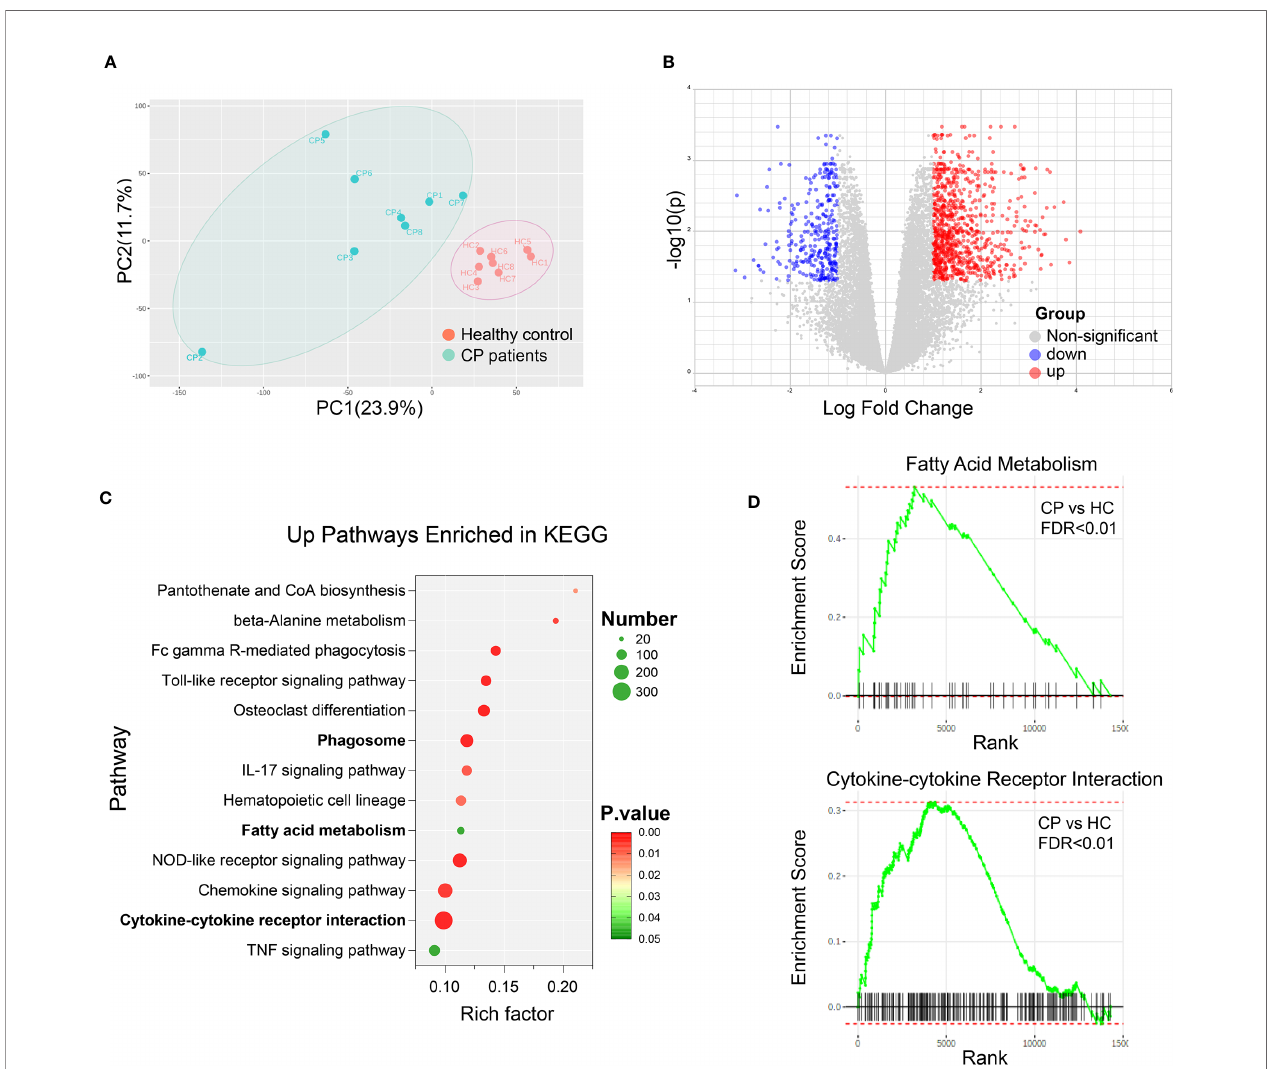
FIGURE 2 | Bile Acid Metabolism is Associated with the Altered Signalings in CP Patients. Peripheral blood mononuclear cells (PBMC) were collected from 8 CP patients along with 8 age-gender matched healthy controls. RNA sequencing and transcript analysis were then performed and gene sets were enriched in KEGG and GSEA. (A) Principal component analysis of healthy controls (HC) and CP patients. (B) Volcano plot of the differentially expressed transcript analysis in CP comparing to HC. (C) Signaling pathways enriched in KEGG with the up-regulated genes in CP compared to HC. (D) Representative signaling pathways, fatty acid metabolism and cytokine-cytokine receptor interaction, enriched in GSEA results comparing CP to